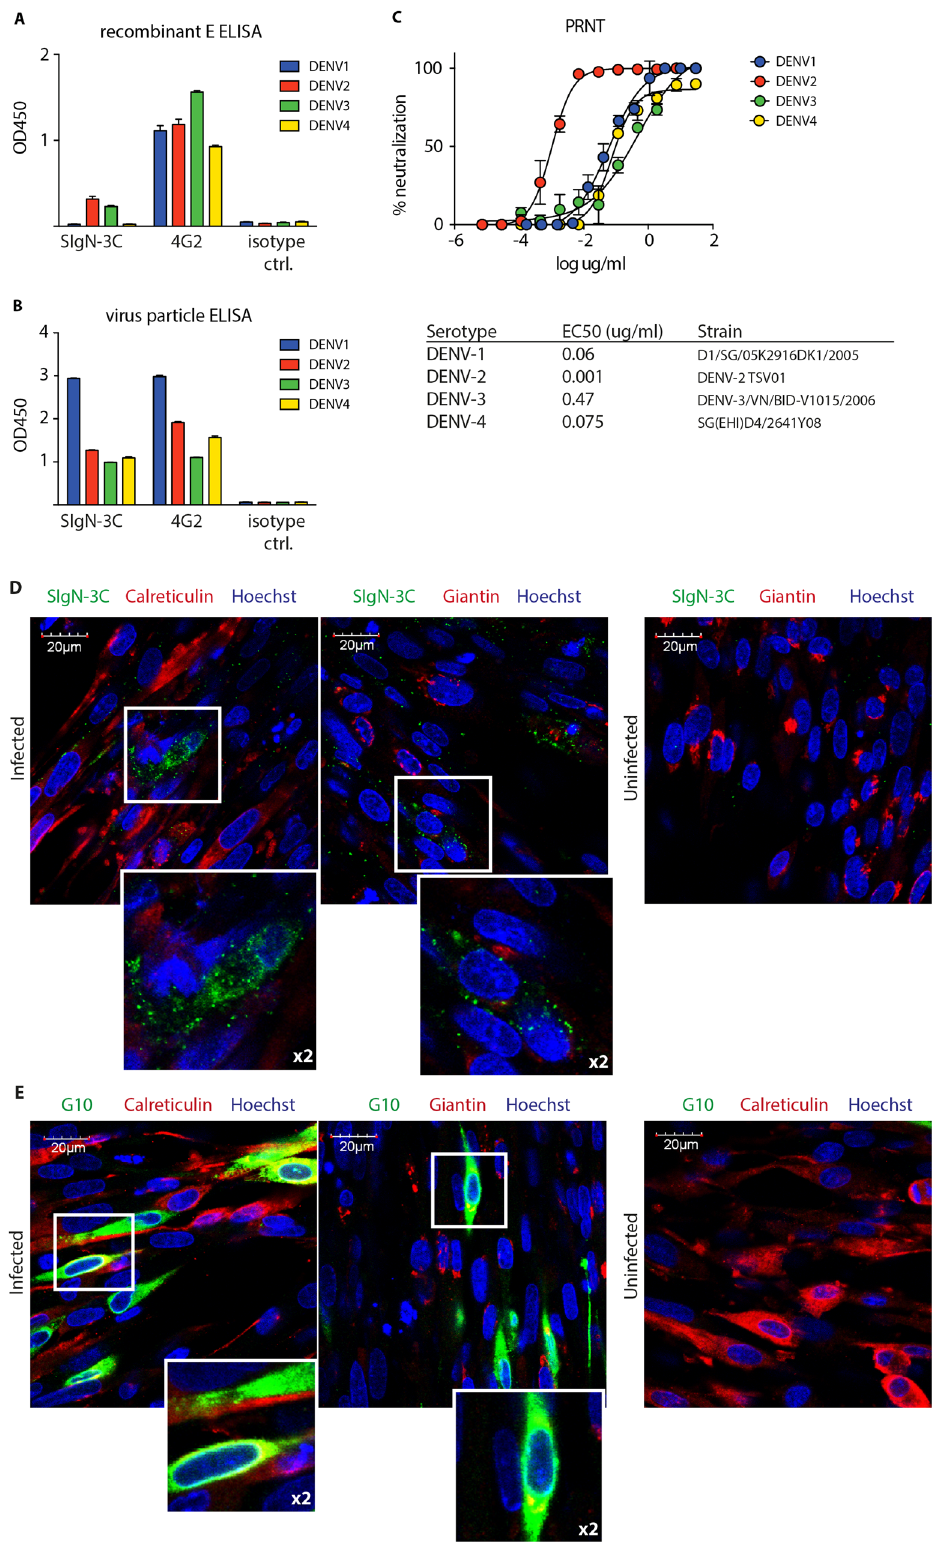
Fig. 1 Distinct binding pattern to a conformational epitope and high neutralizing capacity of antibody SIgN-3C. a rE ELISA for all four DENV serotype, comparing SIgN-3C to fusion-loop speci fi c Ab 4G2. An in fl uenza-speci fi c antibody was used as an isotype control. b Virus particle ELISA for all four DENV serotypes. 4G2 was used as a coating antibody to immobilize non-inactivated virus particles. A and B: bars are means ± SD of triplicates. c BHK-21 cell-based PRNT of SIgN-3C for all four DENV serotypes. Each value is the mean ± SD of triplicates and data are representative of at least two individual experiments. PRNT50 values are indicated below the graph. d , e Immuno fl uorescence of DENV-2 infected BHK-21 cells. Co-stains with Abs against calreticulin or giantin to assess the binding of SIgN-3C ( d ) or fusion loop-speci fi c antibody G10 ( e ) to E protein in the ER or the trans-golgi network, respectively. Boxed sections are 2x magni fi ed to better show co-localization Published in partnership with the Sealy Center for Vaccine Development npj Vaccines (2017)